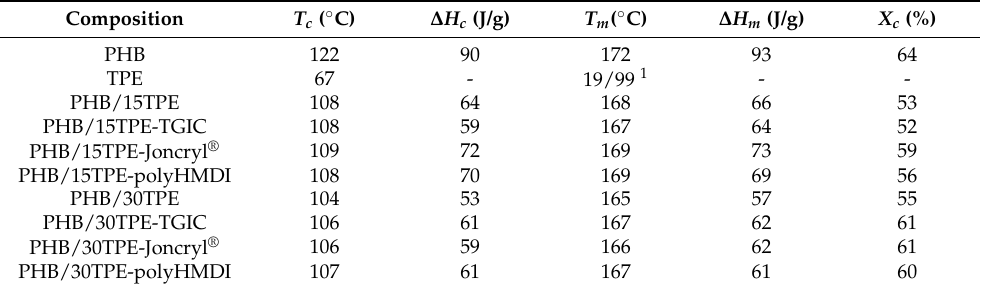
Table 4. DSC data of PHB, TPE, and PHB/TPE 15 and 30 wt% with and without compatibilizers